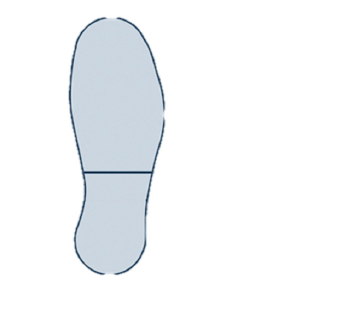
Figure 1. Detecting area division of the fore and rear foot part in loadsol force insole (adapted from [36]).